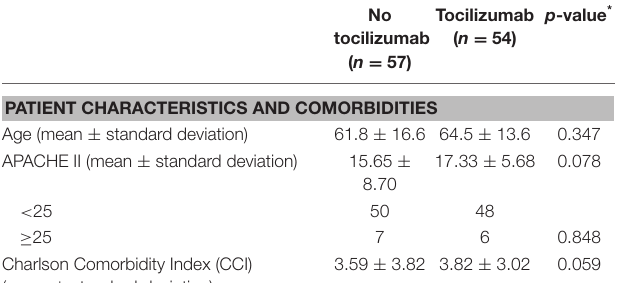
p -value No Tocilizumab tocilizumab ( n = 54) ( n = 57)